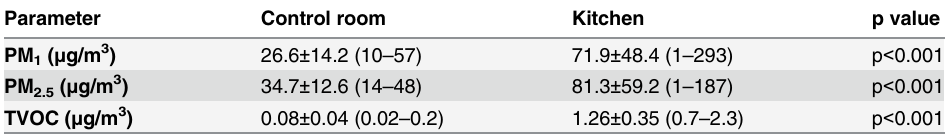
Table 3. PM and TVOC concentration in indoor air at kitchen and control room. Parameter Control room Kitchen p value